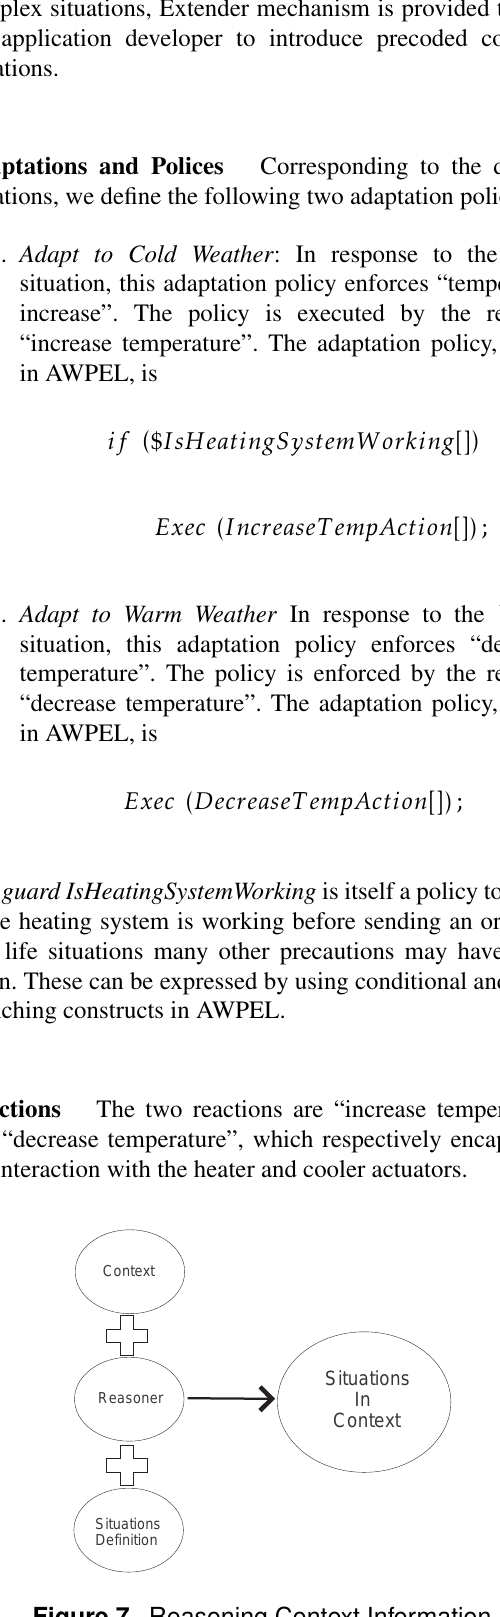
Figure 7. Reasoning Context